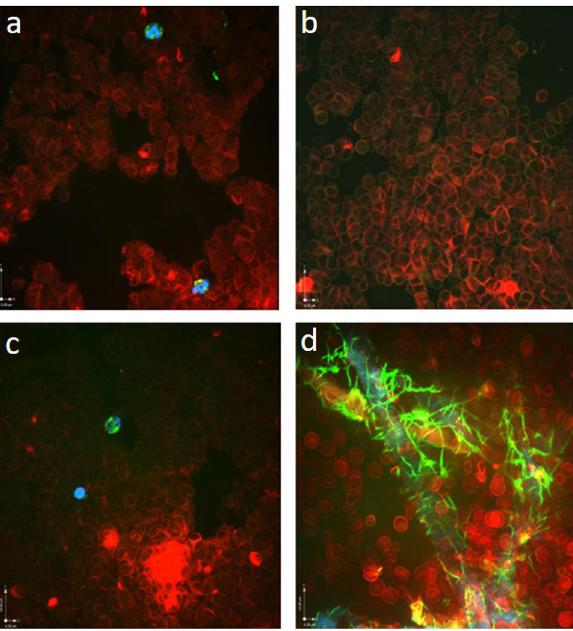
Figure 1. Real time live confocal imaging of human blood (objective 40 × water immersion), displaying aggregated and dried erythrocytes stained with wheat germ agglutinin-Alexa Fluor 555 and fluorescein isothiocyanate-linked Fibrin-Binding Peptide (FITC-FFBP). Cell nuclei, morphology and fibrin were visualized via HOECHST staining (blue). ( a ) Aluminum-coated polyethylene terephthalate: No fibrin network was detected using FFBP solution. Nuclei of two lymphocytes are visible at the top and bottom of the image. Both lymphocytes contain internalized FFBP positive vesicles. ( b ) Polyvinyl chloride: No fibrin network was detected using FFBP solution. ( c ) Polyethylene: at the center of the image the nucleus of a lymphocyte visualized via HOECHST staining (blue), containing internalized FFBP-positive vesicles. No fibrin network was detected using FFBP solution. ( d ) Paper towel: numerous fibrin networks (green) and erythrocytes (red). Notably, most of the fibrin fibers were in close contact with the paper towel fibers.